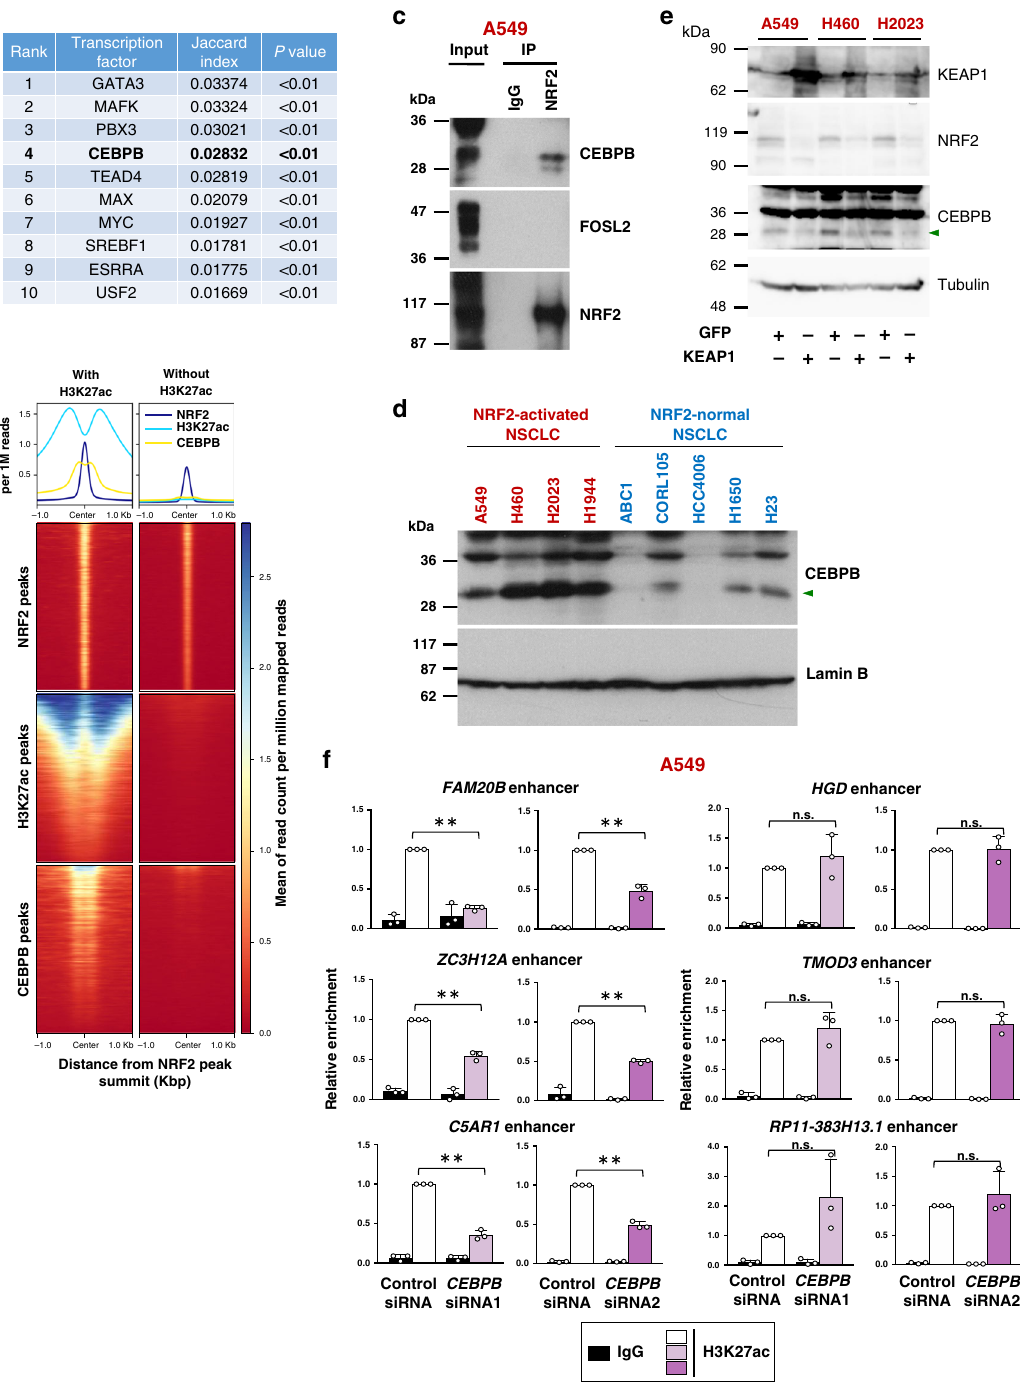
Fig. 6 NRF2 cooperates with CEBPB for enhancer formation in NRF2-activated NSCLCs. a Genome-wide colocalization of NRF2 and other transcription factors at active enhancers marked with H3K27ac deposition in A549 cells. Colocalization tendency was analyzed by Jaccard test using ChIP-seq data deposited in ENCODE. Higher rank indicates better colocalization with NRF2. b Aggregation plots and heat maps of ChIP-seq data of NRF2, H3K27ac, and CEBPB surrounding NRF2 binding sites obtained from the ENCODE database. c Af fi nity puri fi cation of the NRF2 complex from A549 cells. A representative result of two independent experiments is shown. d Immunoblot analysis of CEBPB protein levels in nuclear extracts of four NRF2-activated and fi ve NRF2-normal NSCLC cells. An arrowhead indicates the CEBPB isoform that corresponds to the one detected in the immunoprecipitation experiment with the NRF2 antibody shown in c . Lamin B expression was used as a loading control. The results shown are representative of 2 independent experiments. e Immunoblot analysis detecting KEAP1, NRF2, and CEBPB in three NRF2-activated NSCLC cells with GFP expression (control) or wild-type KEAP1 reconstitution. Tubulin expression was used as a loading control. The results shown are representative of three independent experiments. f ChIP assay using the H3K27ac antibody in A549 cells treated with control or CEBPB siRNA. H3K27ac deposition at NRF2-activated NSCLC-speci fi c NRF2 target loci were examined. The average and SD of three independent experiments are shown. Two-sided con fi dence interval estimation was conducted for knockdown samples incubated with H3K27ac antibody. ** α < 0.01, n.s.: not signi fi